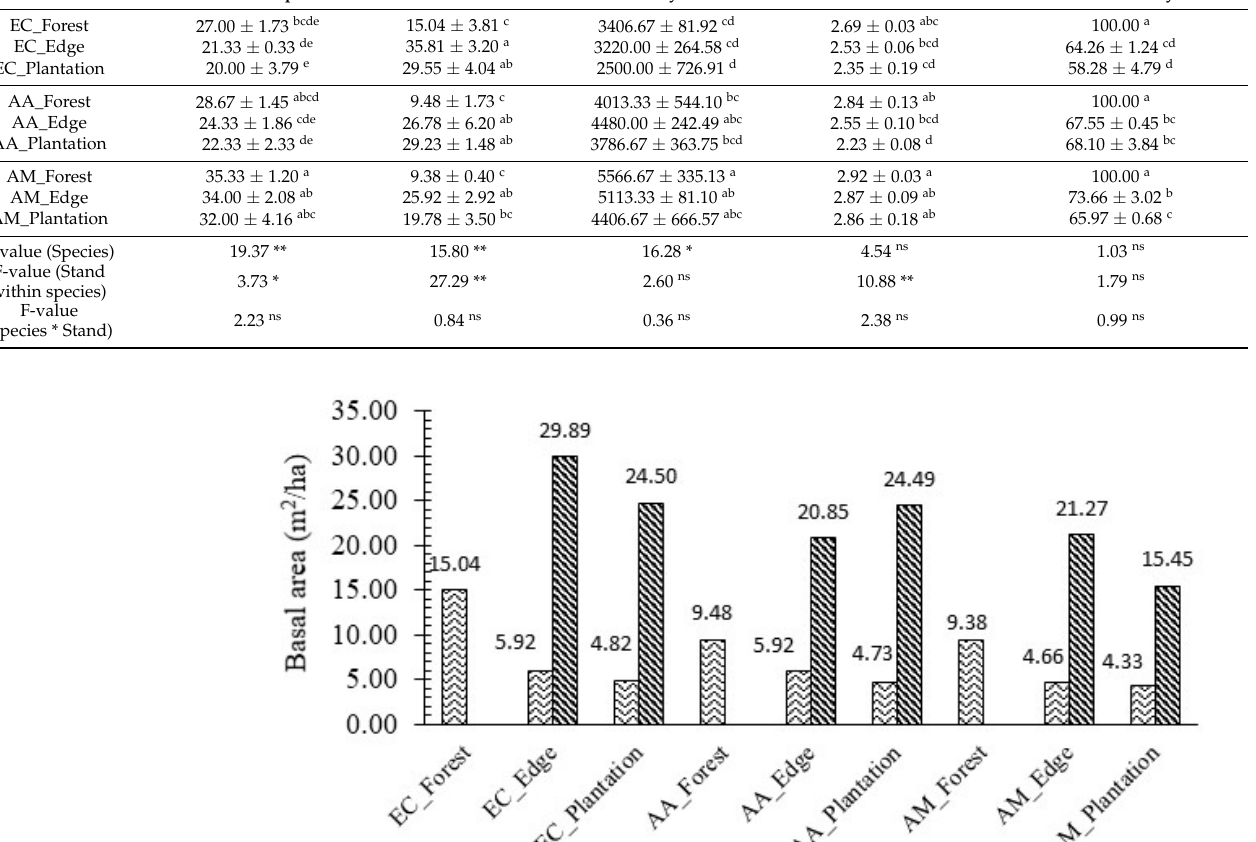
Table 1. Structure and diversity in nine stands of three exotic plantations. EC: Eucalyptus camaldu ‐ lensis , AA: Acacia auriculiformis , AM: A. mangium . Significant differences: ns p ≥ 0.05; * p < 0.05, ** p < 0.01. Different superscript letters in the same column indicate significant difference at p < 0.05.